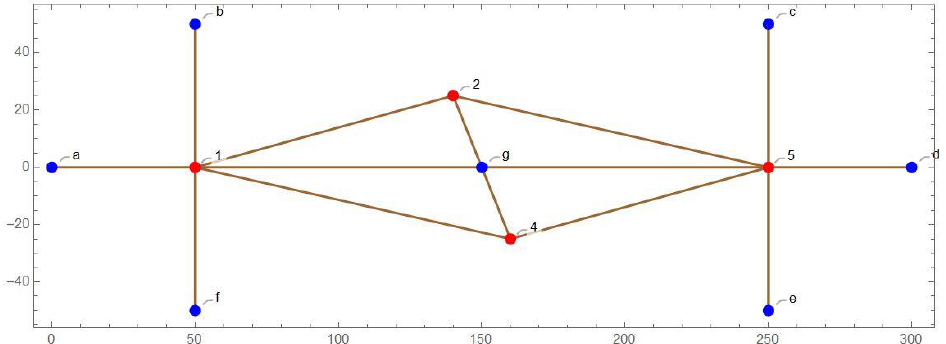
Figure 1. A traverse. Control stations are blue with single-letter designations. Unknown stations are red with number designations. Observed lines are brown.